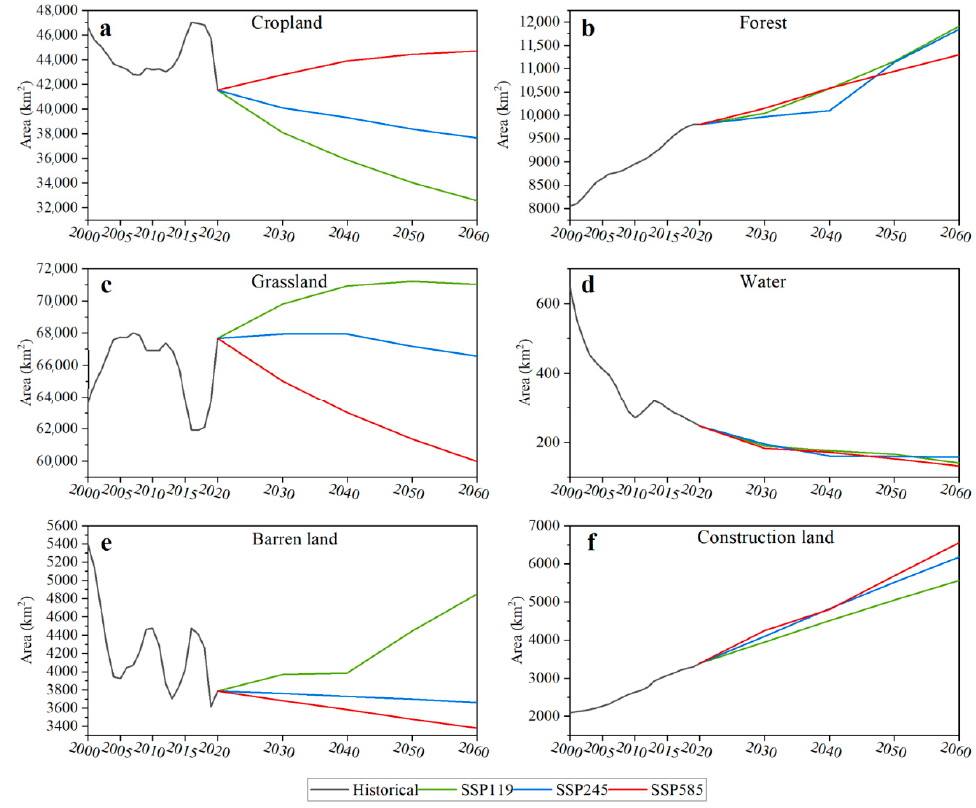
Figure 6. Area statistics of cropland ( a ), forest ( b ), grassland ( c ), water ( d ), barren land ( e ) and construction land ( f ) during the historical period and under the future scenarios.